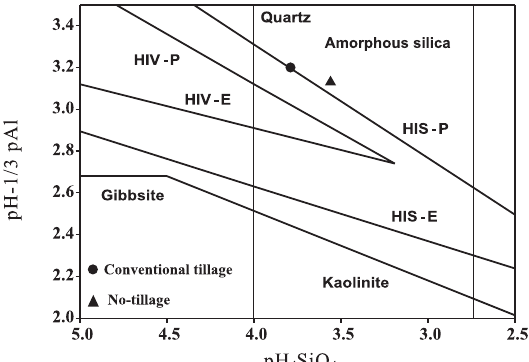
Figure 3. Stability diagram representing the soil solution composition in relation to the stability lines of minerals. HIS-smectite with interlayered aluminum hydroxyl and HIV- vermiculite with interlayered aluminum hydroxyl, with partial (P) and extensive (E)